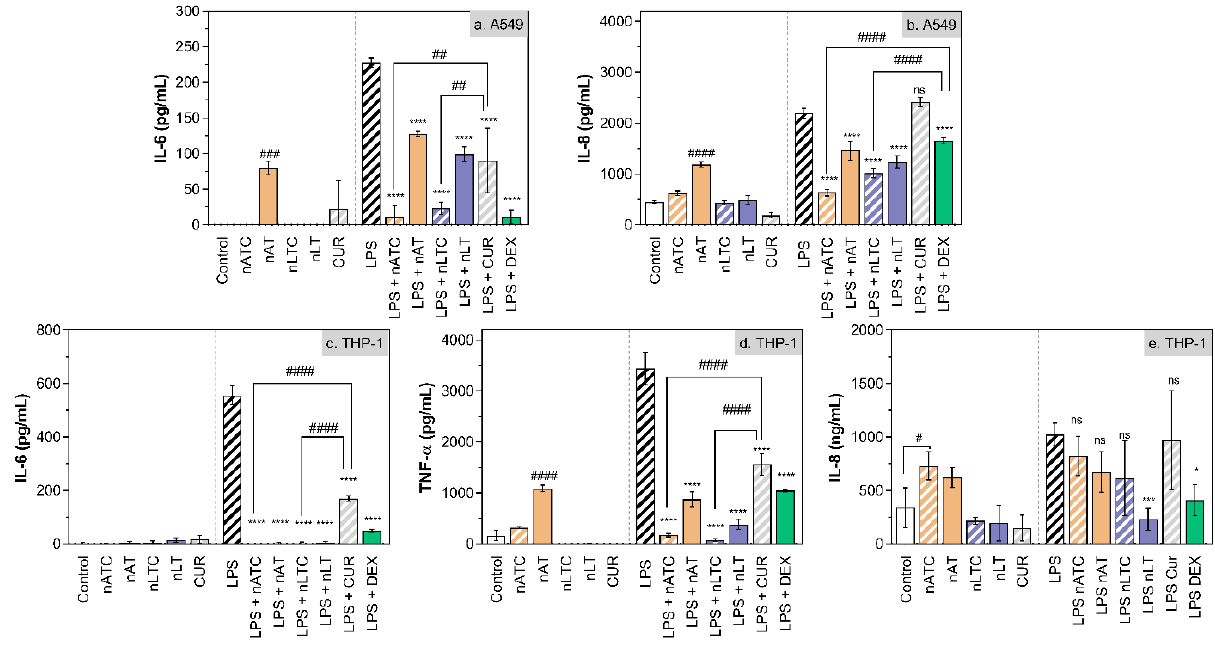
Figure 10. Release of pro-inflammatory cytokines by ( a , b ) A549 and ( c – e ) THP-1 cells upon incubation with 5 µg CUR/mL or 10 µg DEX/mL. Values were analysed using a one-way ANOVA compared with LPS control, * p < 0.05; *** p < 0.001, **** p < 0.0001. Significant differences between treatments were analyzed using a one-way ANOVA, # p < 0.05; ## p < 0.01; ### p < 0.001, #### p < 0.0001.